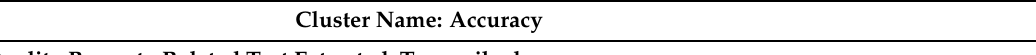
Table A6. Quality Property Cluster: Accuracy.